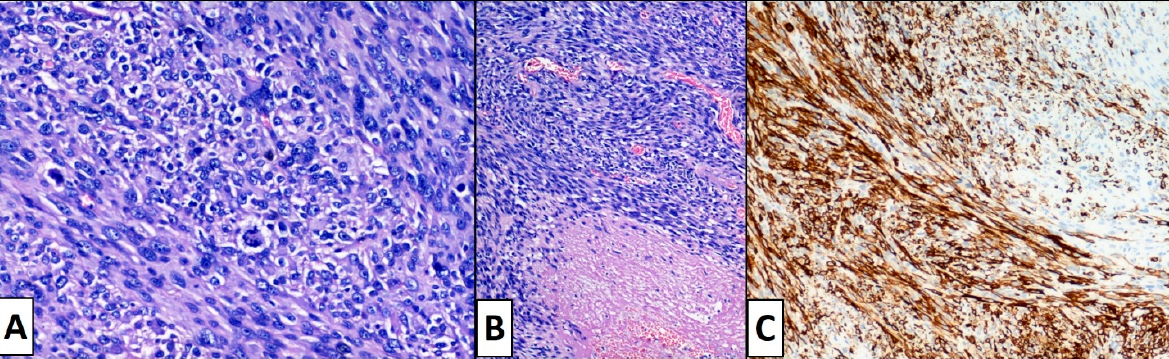
Figure 3. Histopathological features of the leiomyosarcoma. At high magnification the neoplastic spindle cells showed pleomorphic and hyperchromatic nuclei with atypical mitotic figure and extensive necrosis ( A , B ). The tumor cells displayed consistent smooth muscle actin immunoreactivity ( C ).